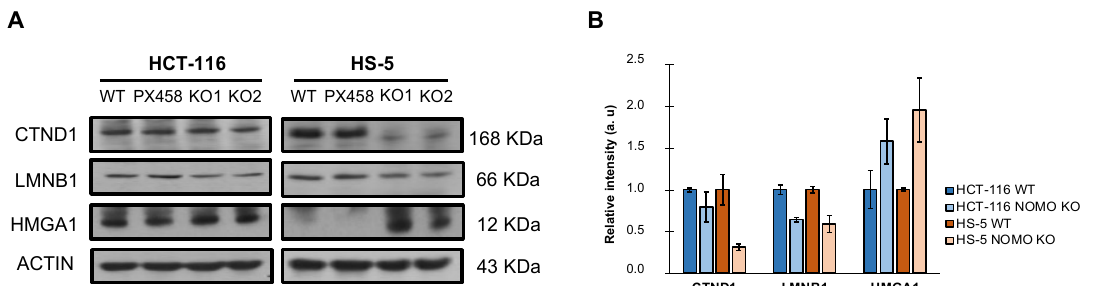
Figure 5. Expression of differentially expressed cell-migration-associated-proteins (CTND1, LMNB1, and HMGA1) in the LC–IMS/MS analysis of the HCT-116 and HS-5 cell lines. ( A ) Western blot analysis showed the differential expression of CTND1, LMNB1, and HMGA1 in NOMO1 knockout cell lines. ( B ) The graph shows the normalized quantification of CTND1, LMNB1, and HMGA1, detected by Western blot, named as relative intensity in arbitrary units